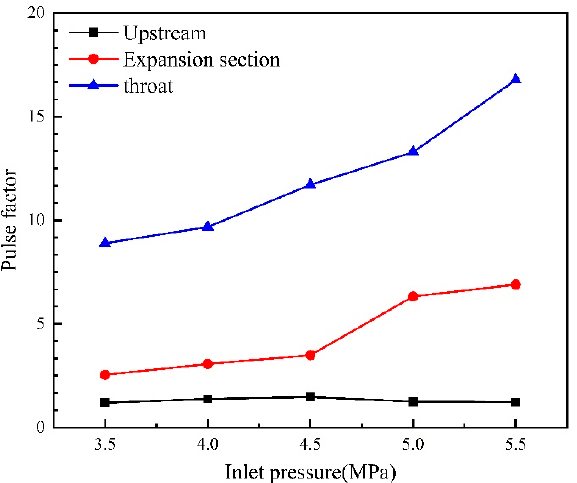
Figure 13. Pressure pulse factor at three measurement points with increasing inlet pressures.